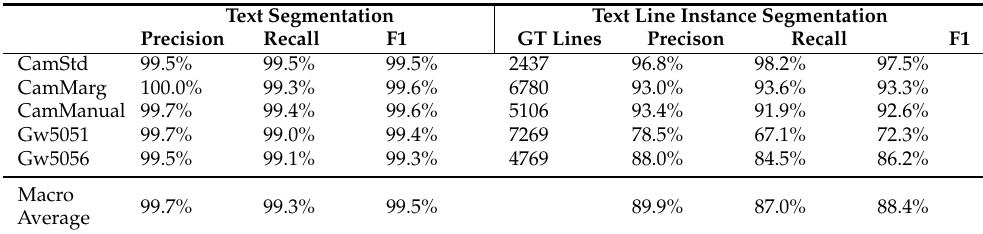
Table 2. Evaluation of the pixel-level text/non-text segmentation and line instance segmentation of the Kraken engine on our evaluation datasets CamStd, CamMarg, CamManual, Gw5051, and Gw5056.